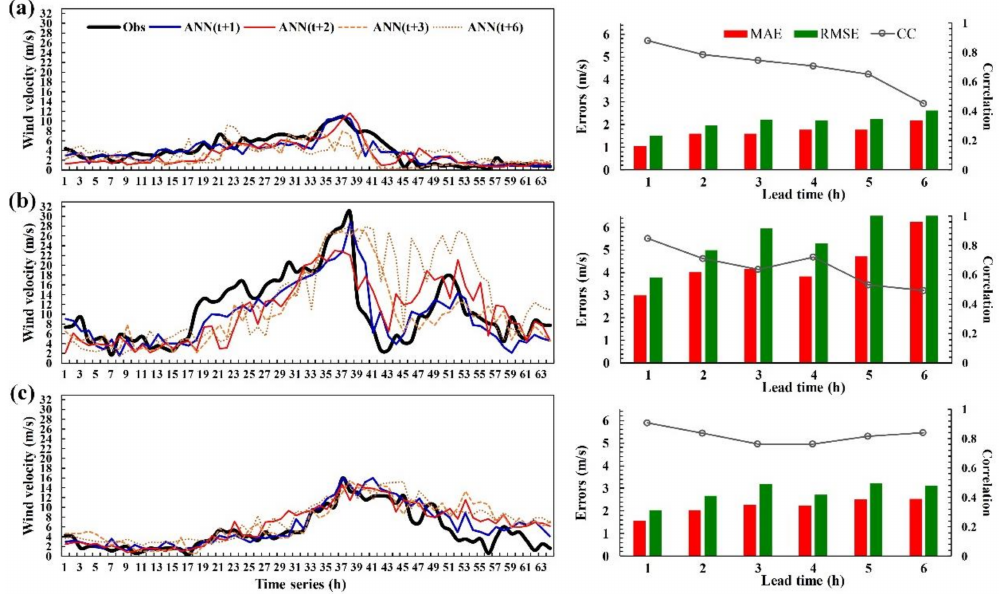
Figure 8. Comparisons between records and 1- to 6-h lead predictions for Soudelor in 2015: ( a ) Hsinchu, ( b ) Wuqi, and ( c ) Kaohsiung